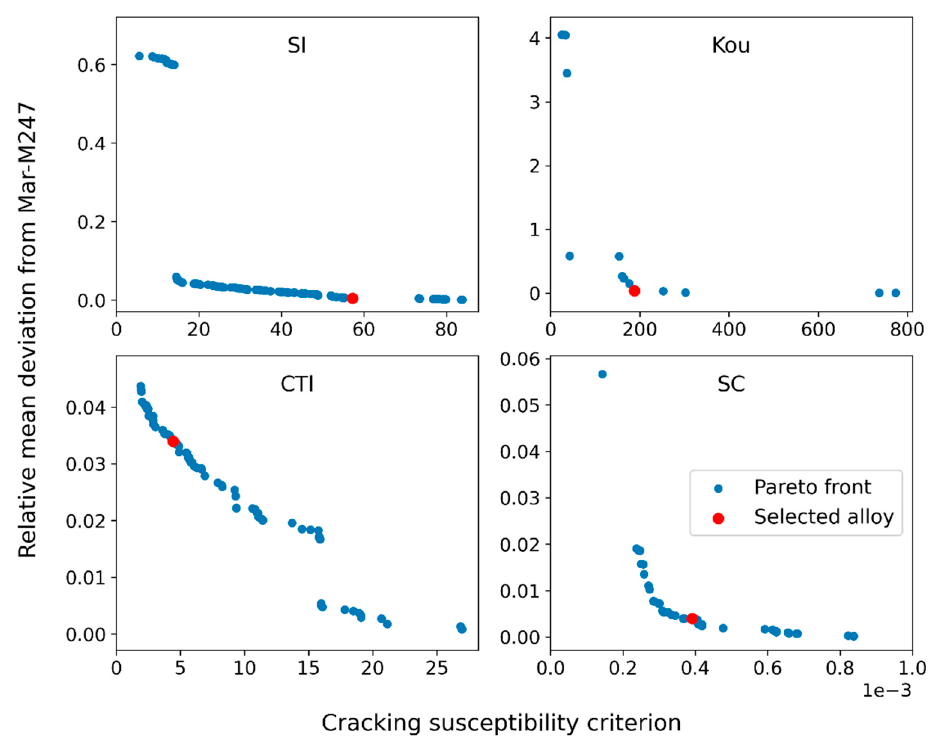
Figure 1. Pareto fronts for optimization of cracking criteria and deviation of crucial properties from Mar-M247. Cracking criteria are solidification interval ( SI ), Kou criterion ( Kou ), critical temperature interval ( CTI ), and shrinkage coefficient ( SC ), cf. Section 2.1. Cracking susceptibility values for ref-